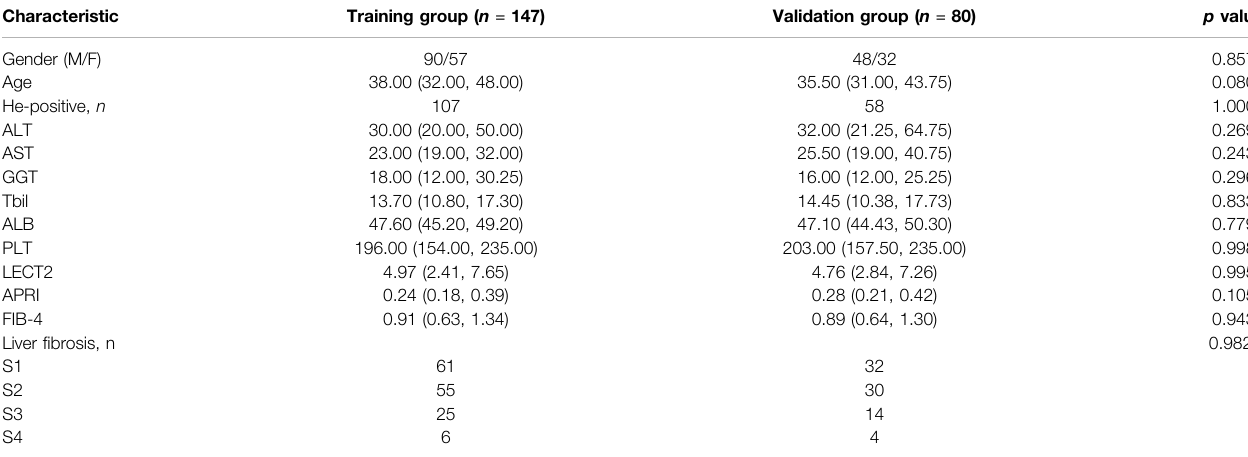
Data are expressed as the median and quartiles. a Fisher ’ s exact